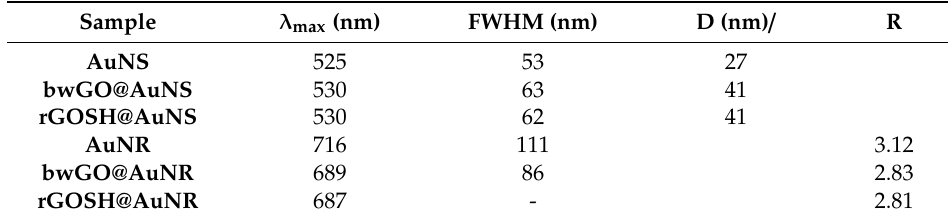
Table 3. Optical parameters of wavelength at the maximum of absorbance ( λ max ) full width at half maximum (FWHM), optical diameter (D) and aspect ratio (R) calculated from the surface plasmon (SP) bands of AuNS, AuNR, and their hybrids with bwGO and rGOSH, according to Equations (1)–(5) in Materials and Methods section.